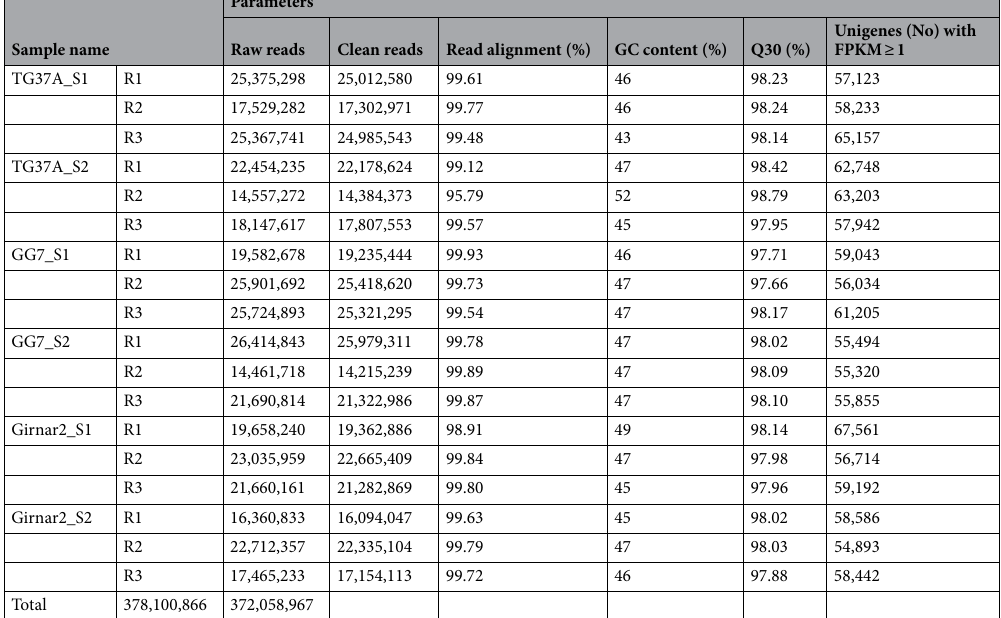
Table 1. Summary of RNA-seq data of three peanut seed samples collected at two stages of maturity. Seed maturity stages are denoted by S1 (maturing stage) and S2 (matured stage). R1, R2, R3 are the three biological replicates of each sample. Q30 = Quality Score 30, FPKM = Fragments Per Kilobase of transcript per Million mapped reads.